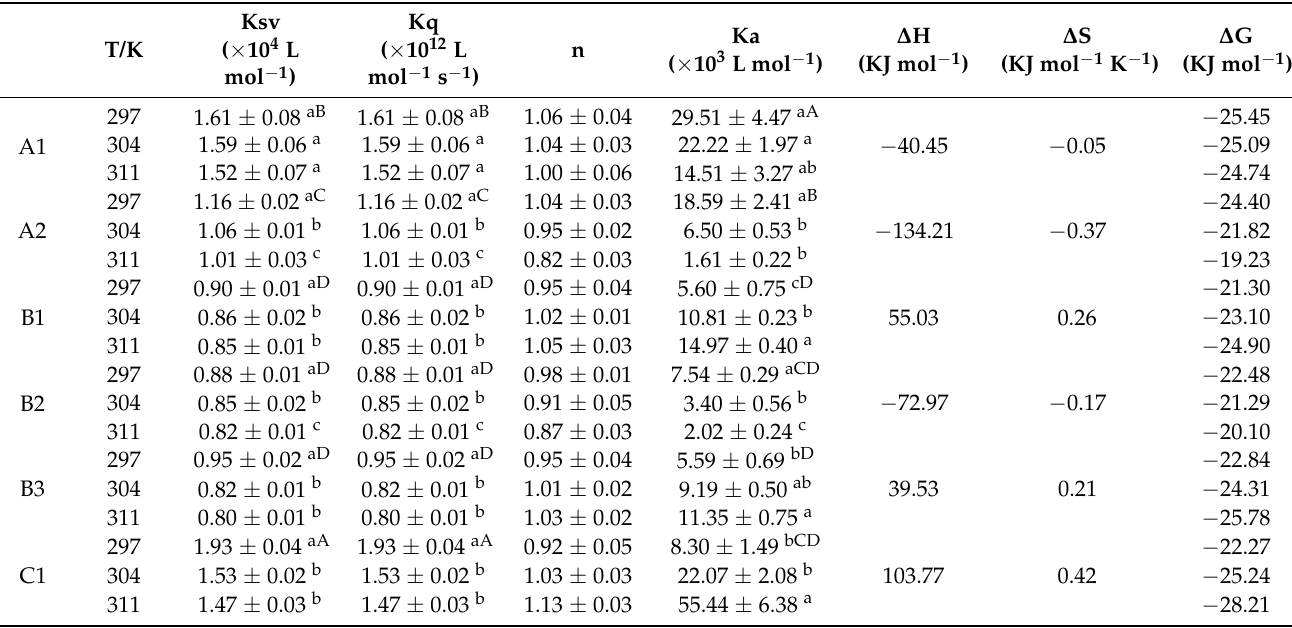
Table 1. Quenching constants, binding constants, and thermodynamic parameters for proanthocyanidin A1, A2, B1, B2, B3, and C1 binding to β -LG at 297, 304, and 311 K.